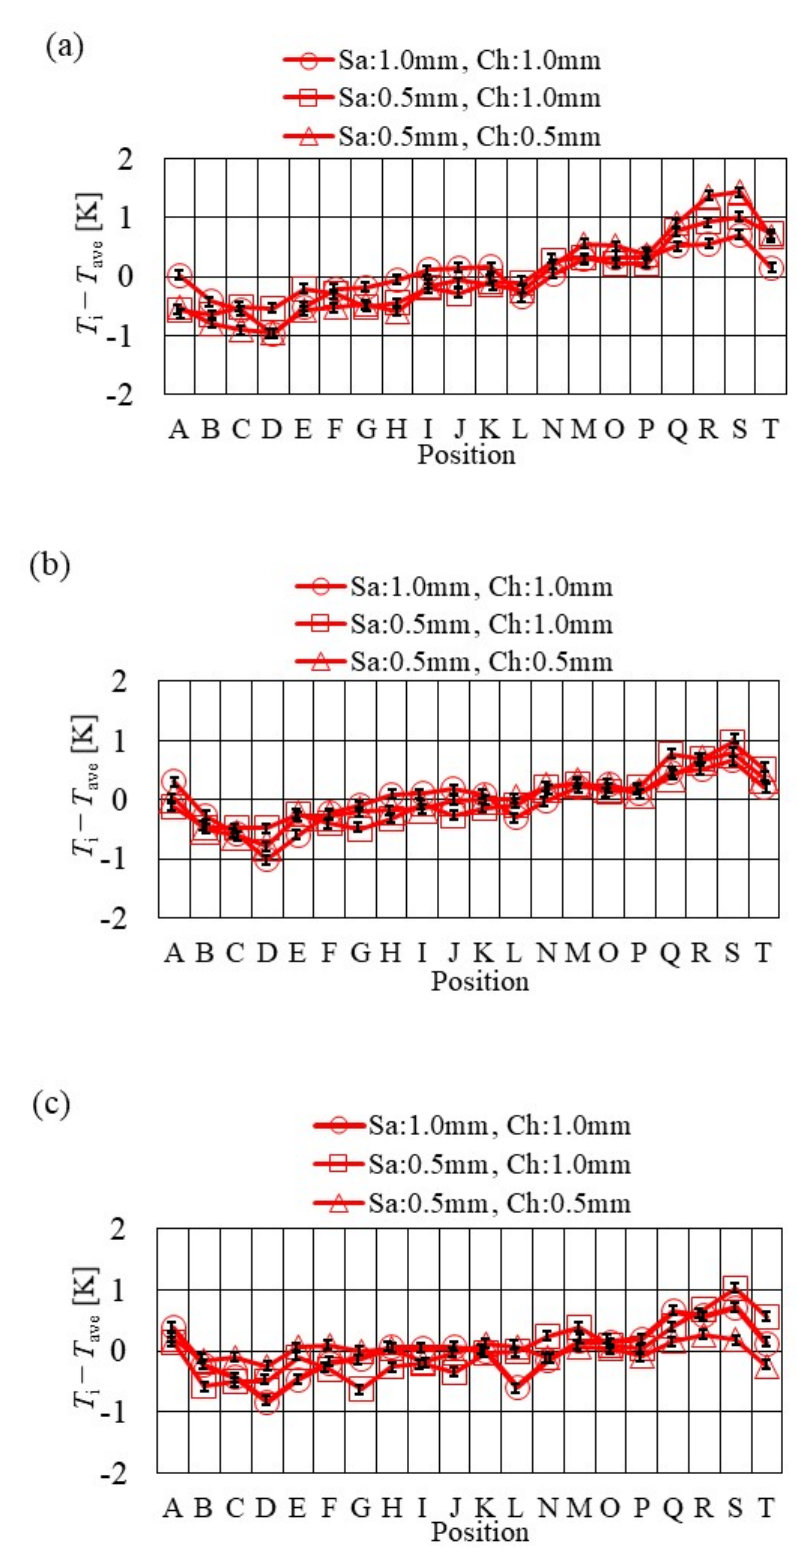
Figure 20. Comparison of in-plane temperature distributions at the cathode side among different separator thicknesses with A40%RH&C40%RH: ( a ) T init = 353 K; ( b ) T init = 363 K; ( c ) T init = 373 K.